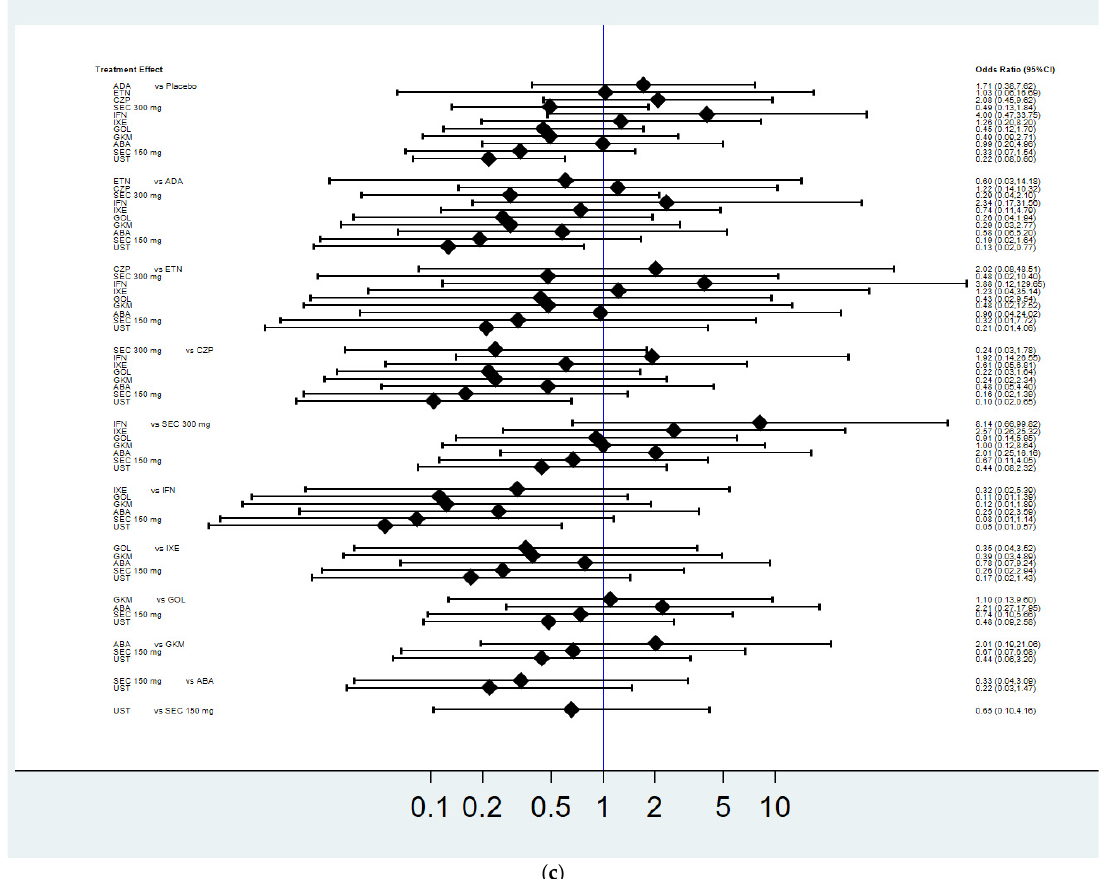
Figure 3. Network meta-analysis for efficacy and safety. ( a ) Radiographic non-progression; ( b ) change in total radiographic score; ( c ) discontinuation due to adverse events. PBO: placebo; IFN: infliximab; ADA: adalimumab; UST: ustekinumab; GOL: golimumab; ABA: abatacept; SEC: secukinumab; CZP: certolizumab pegol; ETN: etanercept; IXE: ixekizumab; GKM: guselkumab.